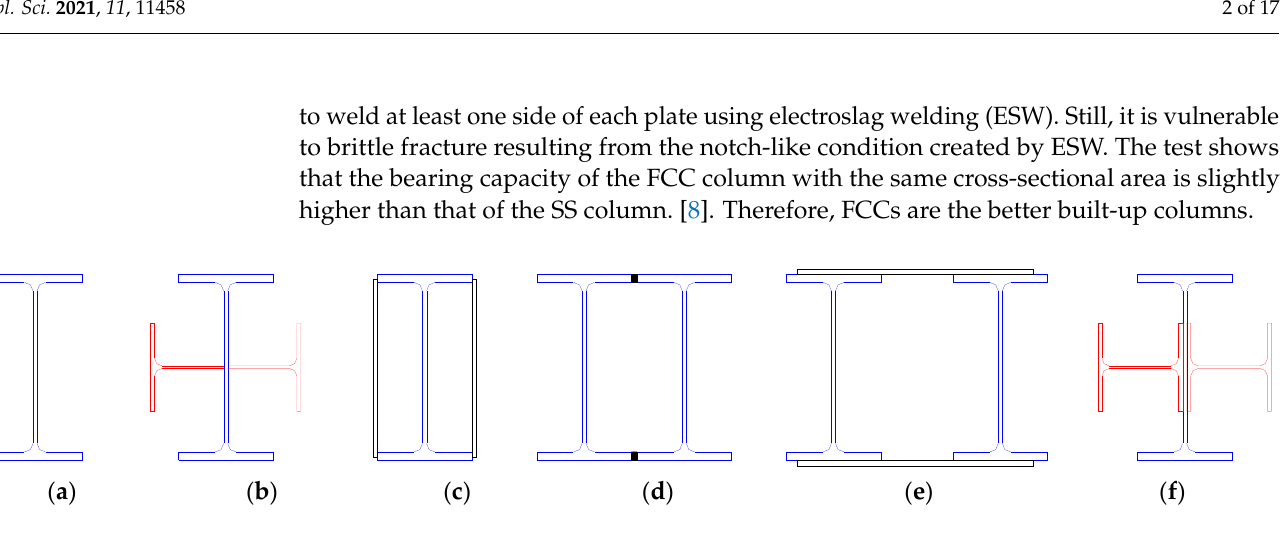
Figure 1. The typical of built-up columns with H-shape: ( a ) UC or UB; ( b ) FCC; ( c ) BWS; ( d ) SS; ( e ) BBC; ( f ) FCHC.